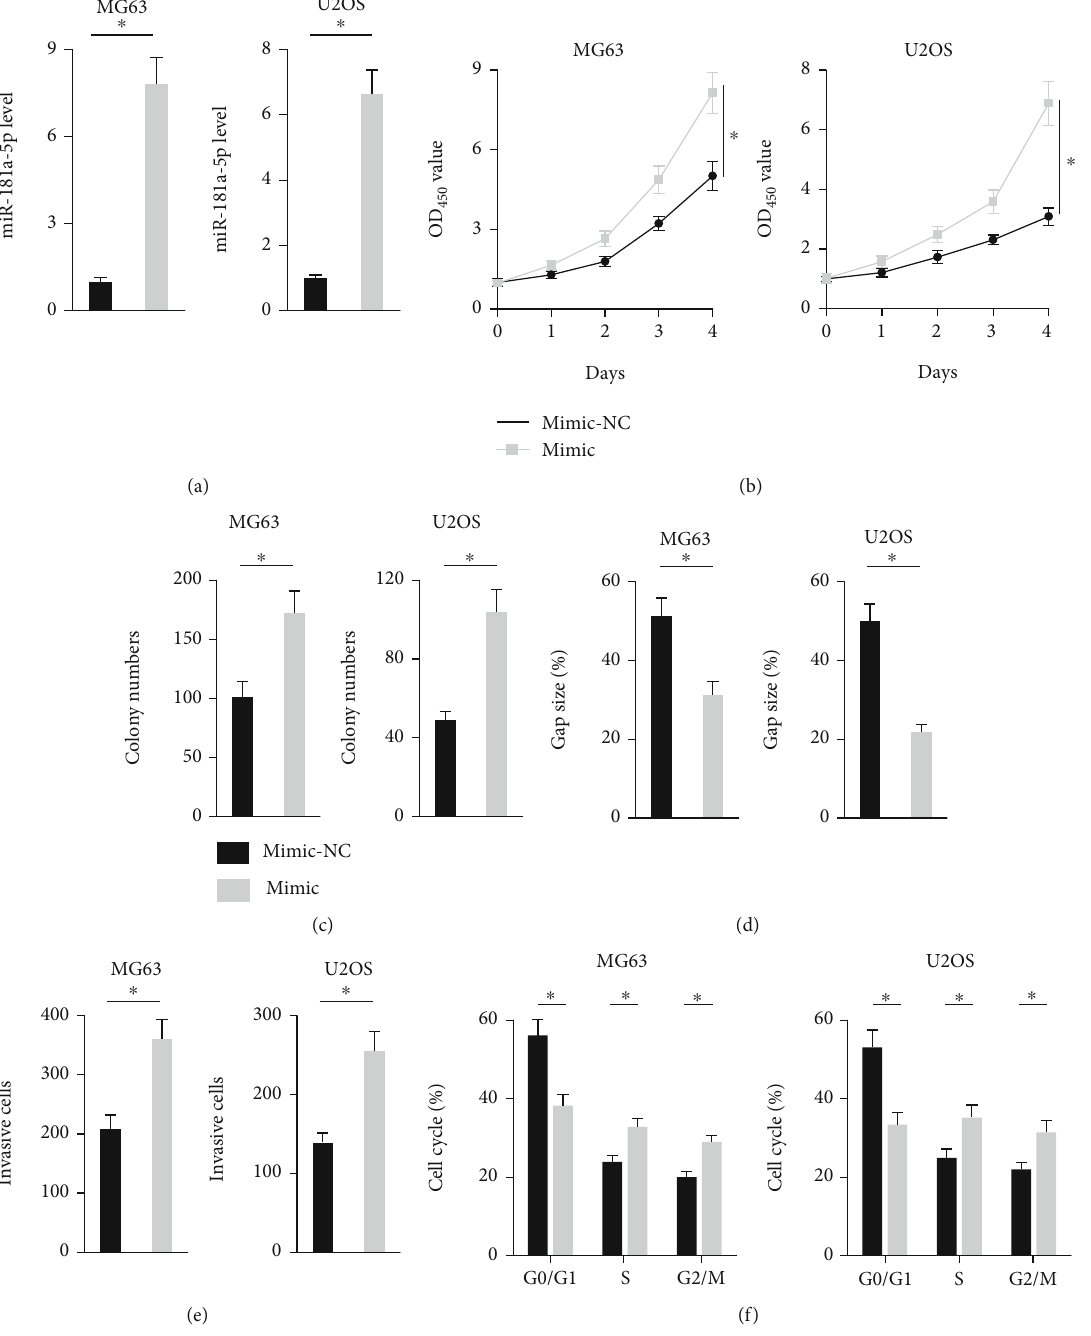
Figure 3: miR-181a-5p mimic promotes osteosarcoma progression in vitro. (a) Relative miR-181a-5p level in osteosarcoma cells treated with or without miR-181a-5p mimic ( n = 6 ). (b) Cell viability of osteosarcoma cells determined by CCK-8 assay ( n = 6 ). (c) Colony numbers in osteosarcoma cells with or without miR-181a-5p mimic treatment ( n = 6 ). (d) Gap size in the wound healing experiments ( n =5). (e) Invasive cells in transwell experiments with or without miR-181a-5p mimic treatment ( n = 6 ). (f) Cell cycle distribution in di ff erent phases ( n = 5). All data are presented as the mean ± SD , ∗ P < 0 : 05 versus the matched